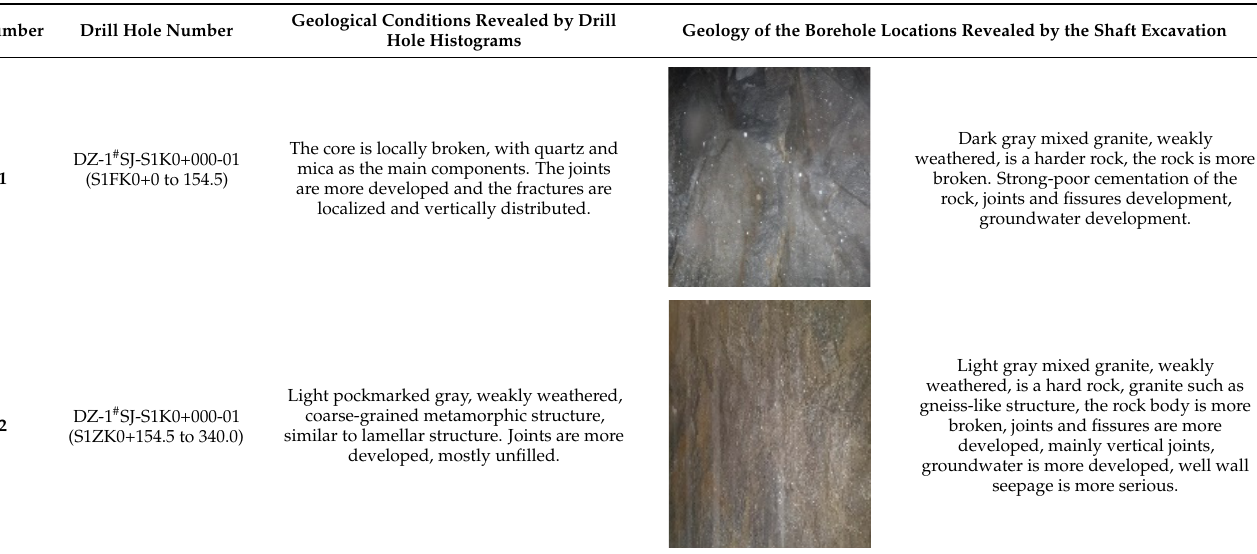
Figure 3. Core images of No. 1 shaft sub shaft. ( a ) 101.3 to 114.0 m; ( b ) 269.10 to 280.50 m; ( c ) 380.60 to 391.70 m; ( d ) 456.10 to 466.00 m; ( e ) 601.30 to 611.50 m; ( f ) 666.80 to 678.70 m. Table 1. Lithology of strata at different depths.